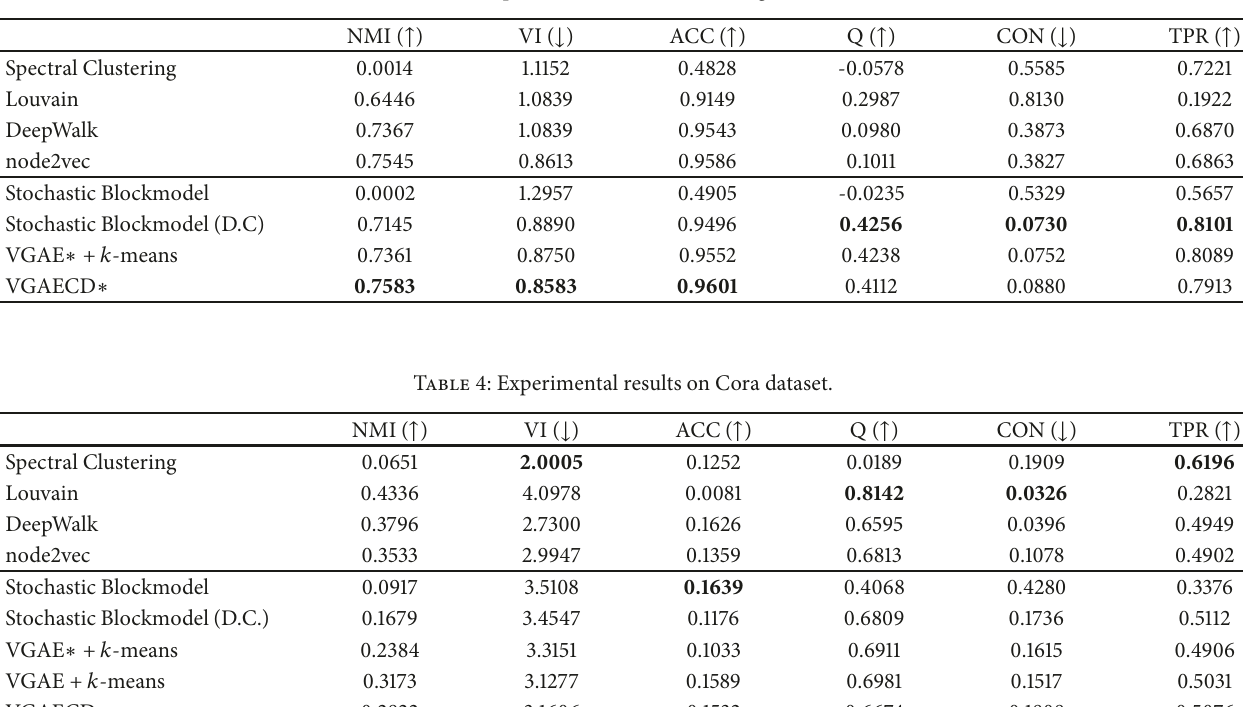
Table 3: Experimental results on PolBlogs dataset.